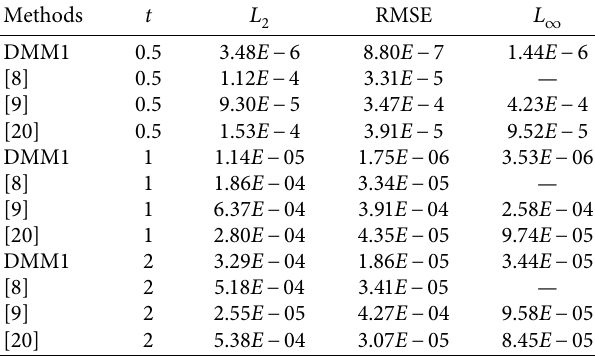
Table 5: Numerical results with α � 10and β � 0 for Example 4. Methods